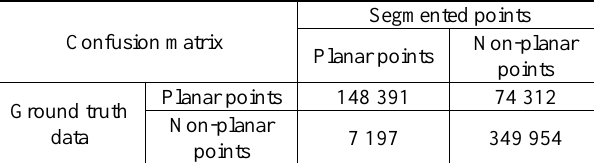
Table 7. Confusion matrix of PCA's results